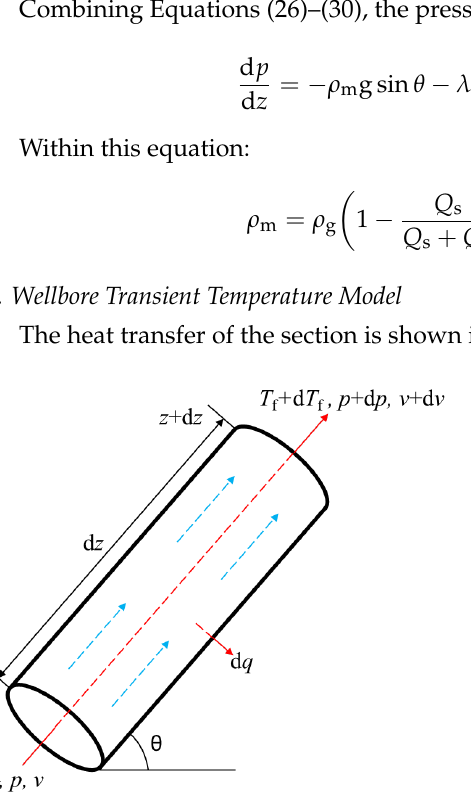
Figure 4. Schematic diagram of section heat transfer.